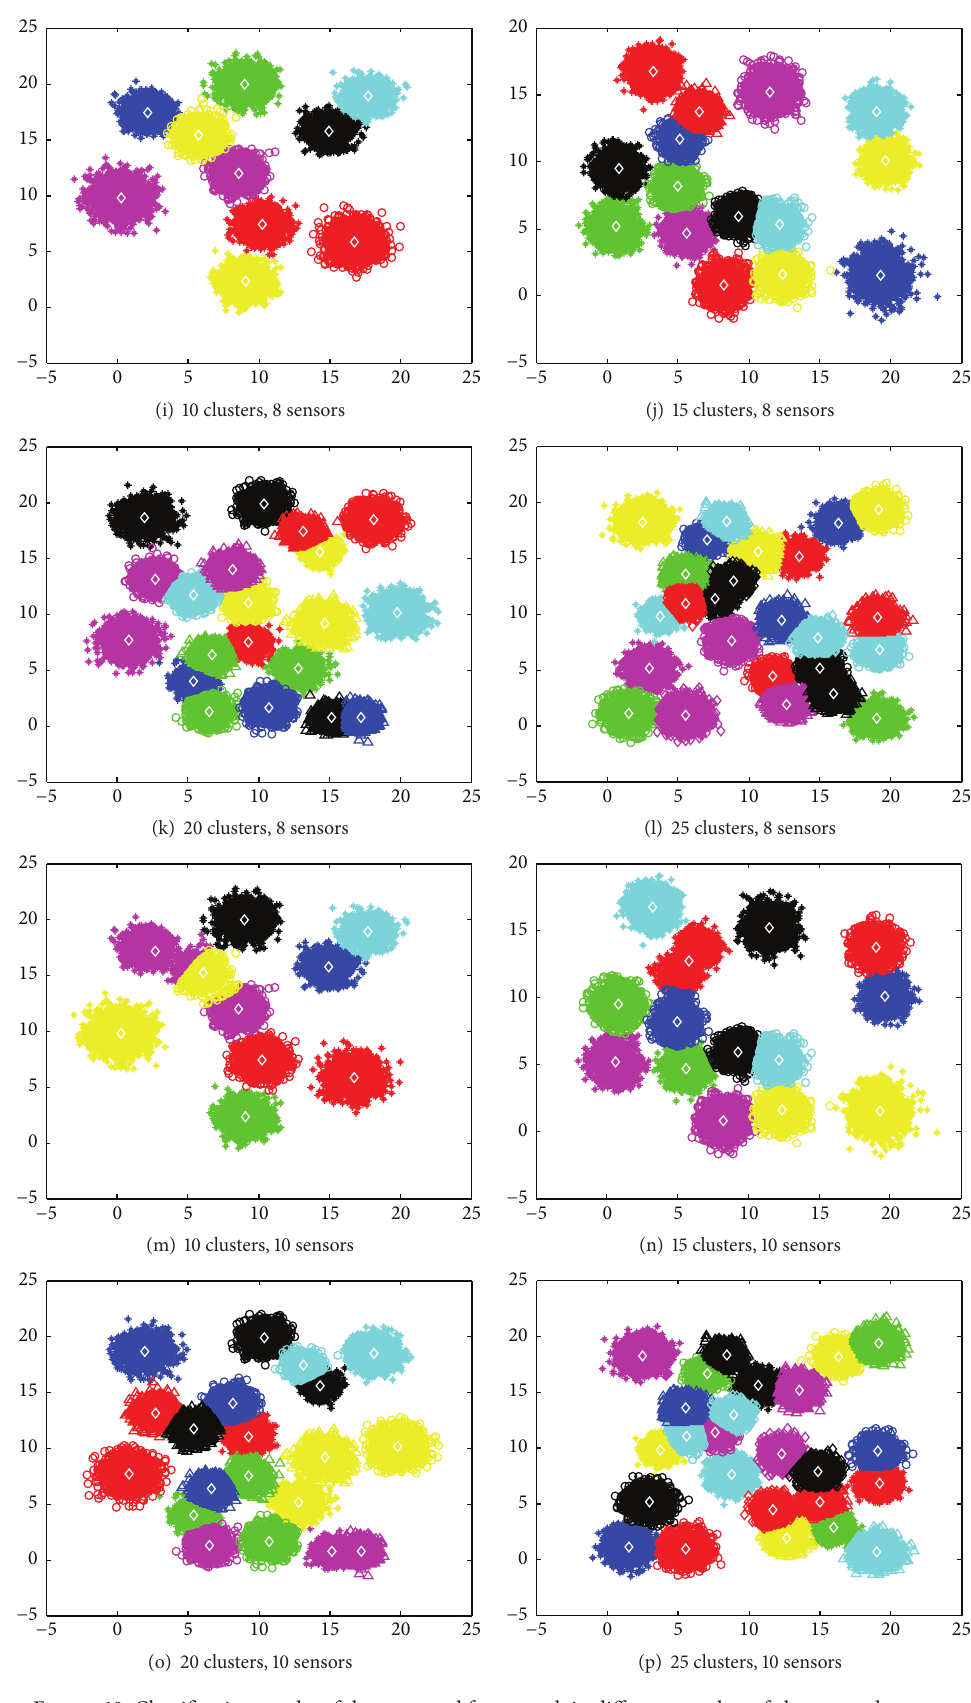
Figure 10: Classification results of the proposed framework in different number of clusters and